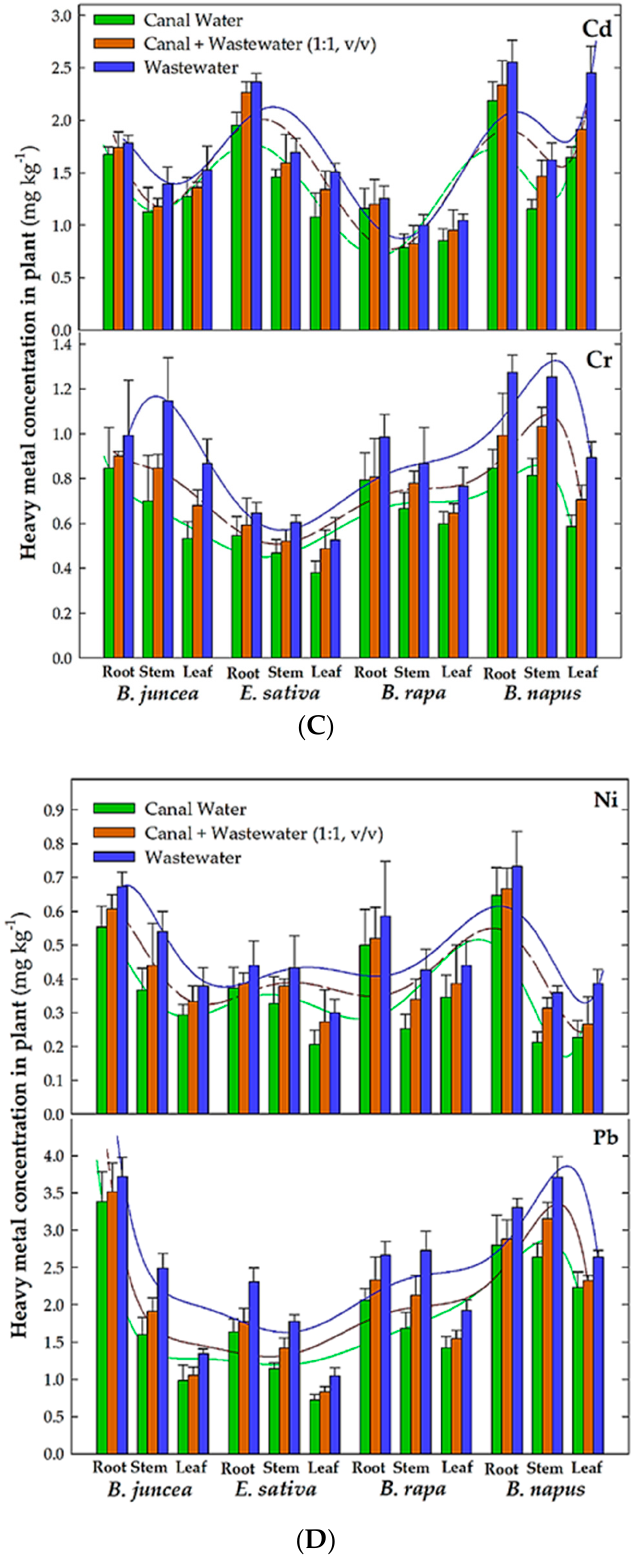
Figure 1. Impact of irrigation water type on Zn and Cu ( A ), Fe and Mn ( B ), Cd and Cr ( C ), and Ni and Pb ( D ) concentrations (mg kg − 1 dry weight) in the root, stem, and leaf of B. juncea , E. sativa , B. rapa and B. napus in a pot experiment. Bars and line of same color represent one water type. The statistical significances or p values (instead of significance letters on bars) are provided in Table 2.